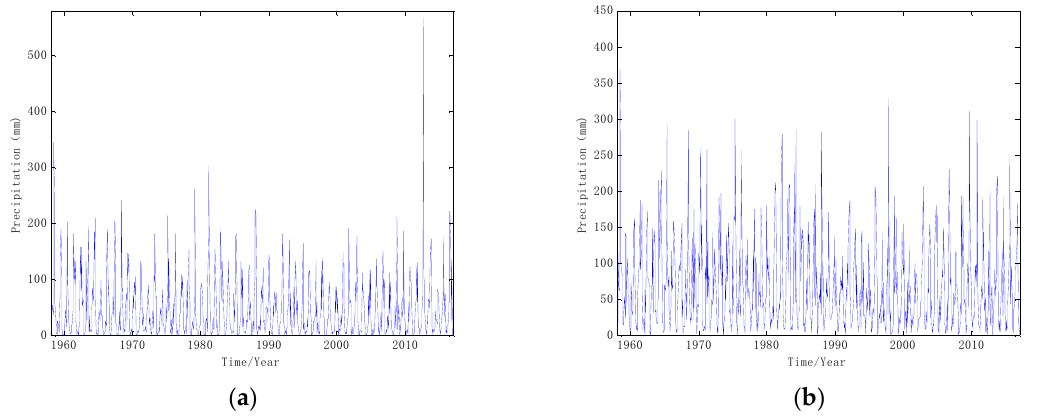
Figure 3. Monthly Precipitation Time Series from 1958 to 2017 of ( a ) Yan’an; ( b ) Huashan.